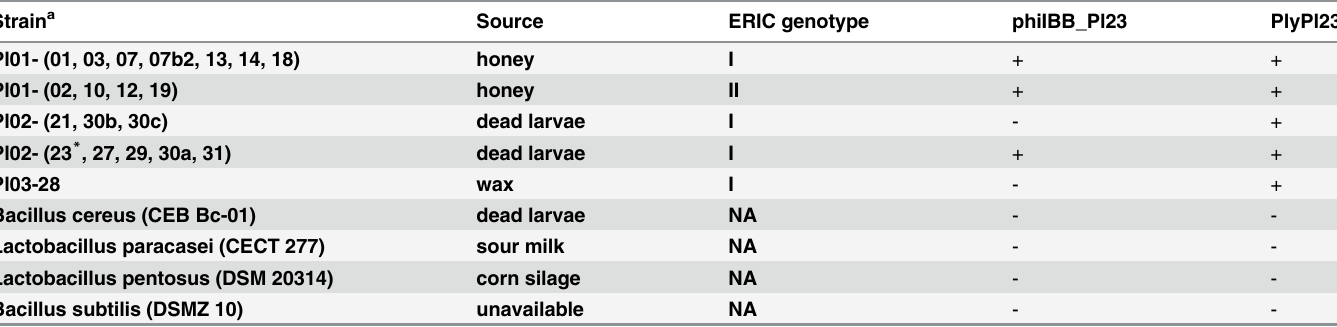
Table 2. Lytic spectra of PlyPl23 and the phage phiIBB_Pl23 against 20 P . larvae , 2 Bacillus and 2 Lactobacillus strains. NA: Non applicable. Strain